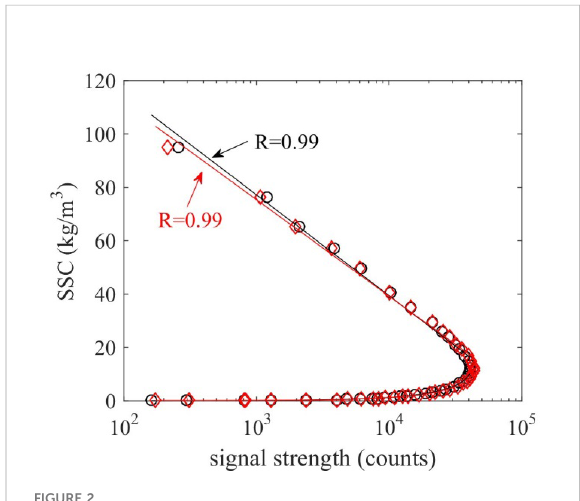
FIGURE 2 Regression relationship between the Obs3+ ’ s signal strength and the